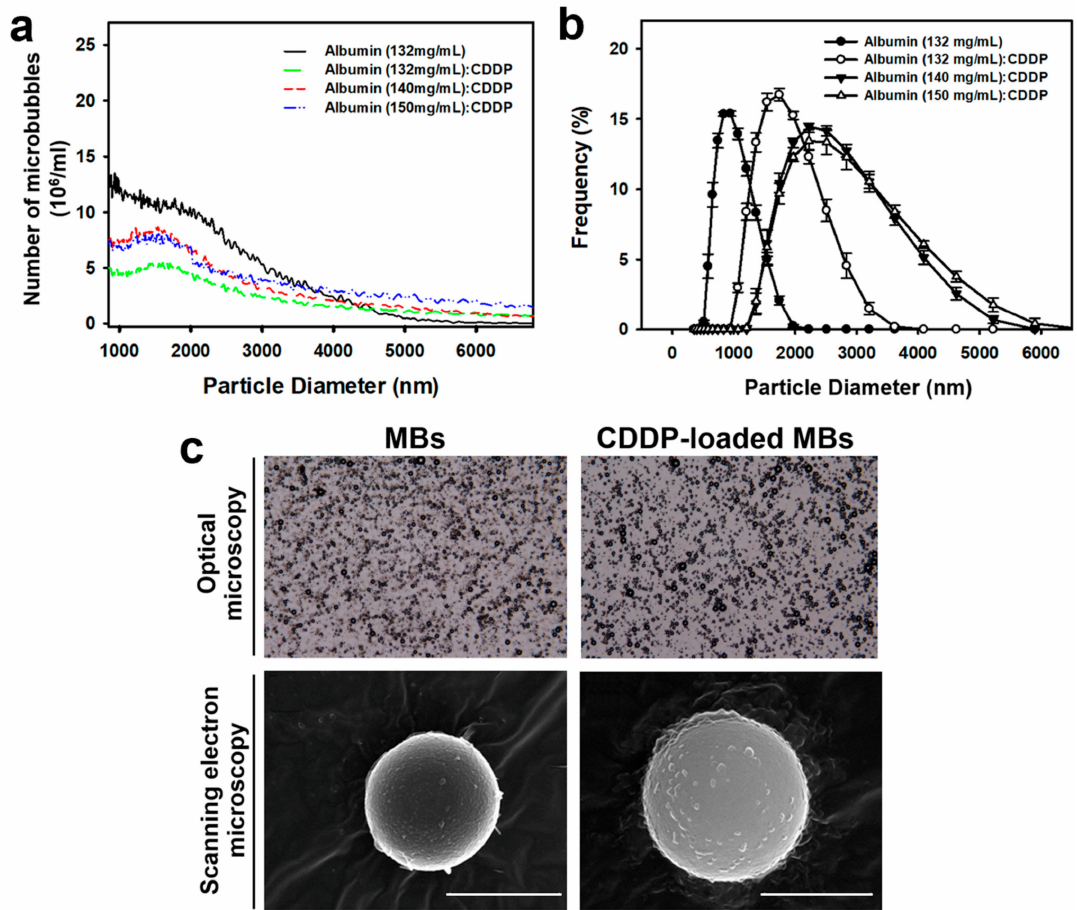
Figure 1. Quantification and light and scanning electron microscopy images of unloaded MBs (MBs) and cisplatin-loaded MBs (CDDP-MBs). ( a ) The number-dependent and ( b ) frequency-dependent size distribution of various MBs. Values are expressed as mean ± SEM ( n = 5); ( c ) Representative light microscopy and scanning electron microscopy images of MBs and CDDP-MBs. Scale bar = 2 µ